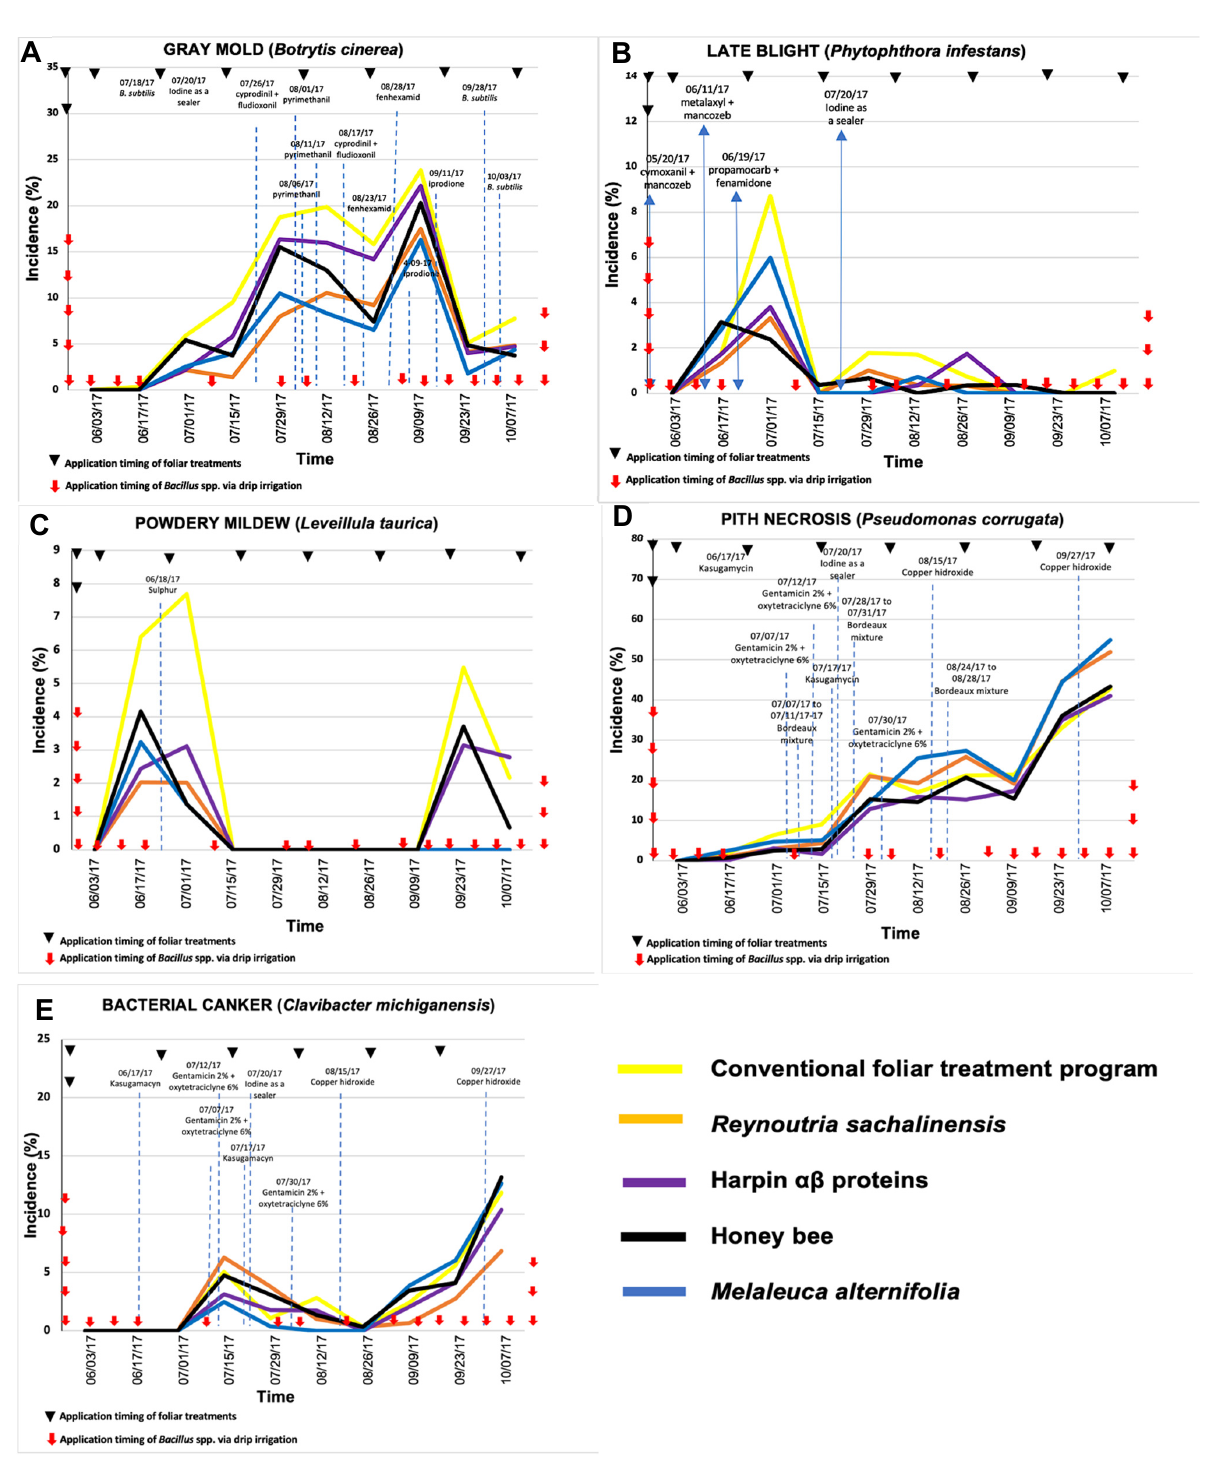
Figure 3. Temporal progress of major tomato diseases—( A ) gray mold ( Botrytis cinerea ), ( B ) late blight ( Phytophthora infestans ), ( C ) powdery mildew ( Leveillula taurica ), ( D ) pith necrosis ( Pseudomonas corrugata ), and ( E ) bacterial canker ( Clavibacter michiganensis )—in five different treatment combinations consisting of soil application of Bacillus spp. Via drip irrigation and foliar application of biorational products in tomato greenhouse production in Experiment 1 in 2017. Dotted vertical lines in graphs indicate the approximate timing of application of fungicides in the conventional management program or in any other treatment due to low-intensity tolerance to disease. Incidence values are the average of three replications.